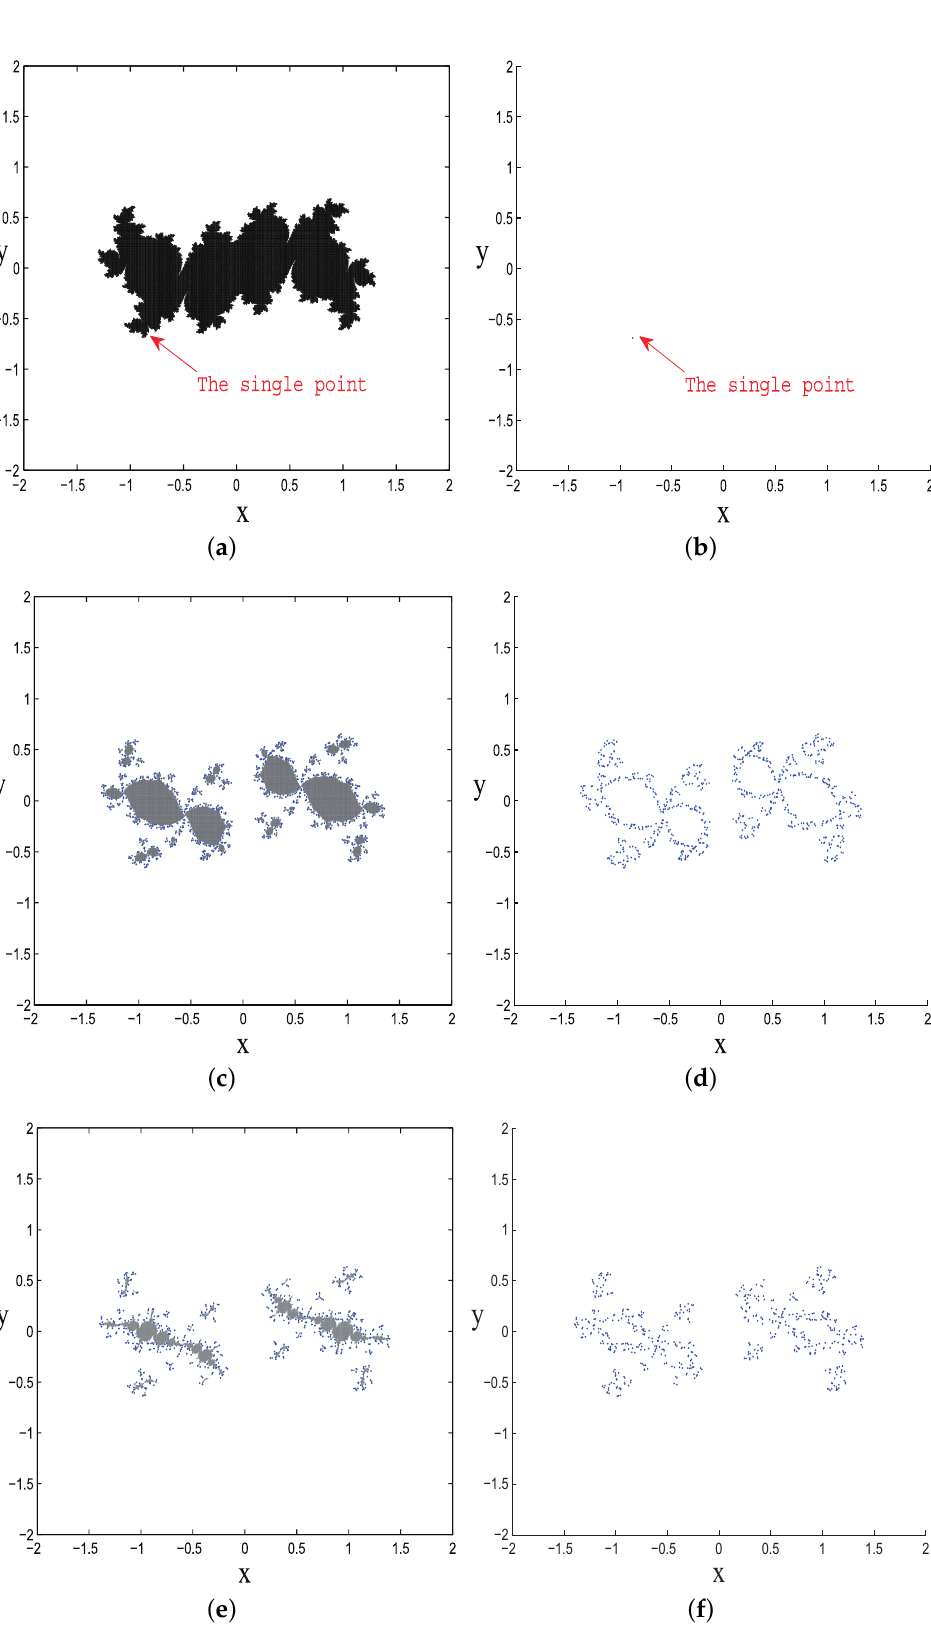
Figure 5. The filled Julia sets of system F 1 with different brightness based on Co . ( a ) c 1 = 0.32 + 0.3 i , ( c ) c 1 = 0.8, c 2 = 0.32 + 0.3 i , ( e ) c 1 = − ς p ,1 corresponding to ( a , c , e ).